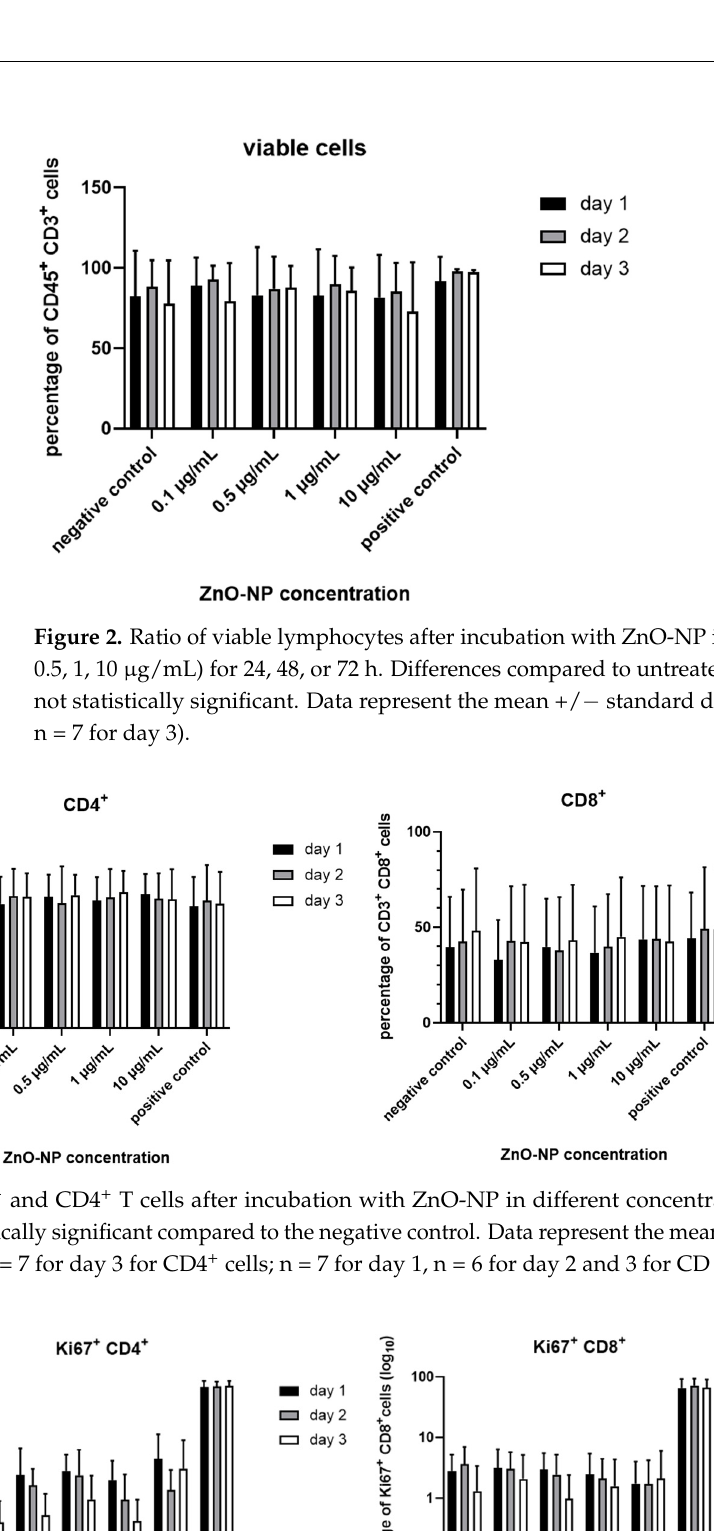
Figure 5. Expression of CD69 and CD38 in CD4 + and CD8 + T cells. The expression tends to decrease over time, although changes are not statistically significant. Results are presented logarithmically. Data represent the mean +/ − standard deviation (n = 9 for day 1 and 2, n = 7 for day 3 for CD4 + cells; n = 7 for day 1, n = 6 for day 2 and 3 for CD 8 + cells). 3.4. CD4 + T Cell Differentiation and HLA-DR Expression Expression of HLA-DR was analyzed on CD3 + lymphocytes and in the CD4 + T cell subset. Figure 6 shows that the measurable expression declined independent of time in the samples which were treated with 0.1 and 0.5 µg/mL ZnO-NP, and increased after in- cubation with 1 and 10 µg/mL in both groups. These observations were particularly no- ticeable on the first and second day of NP treatment. The influence of NP exposure on CD4+ T cell differentiation was evaluated by ana- lyzing the occurrence of CD3 + CD4 + CD45RA + FoxP3 – naïve and CD3 + CD4 + CD45RA – FoxP3 – memory CD4 + cells, CD3 + CD4 + CD45RA + FoxP3 low resting regulatory T cells (rTreg), CD3 + CD4 + CD45RA – FoxP3 high activated Treg (aTreg) and CD3 + CD4 + CD45RA –